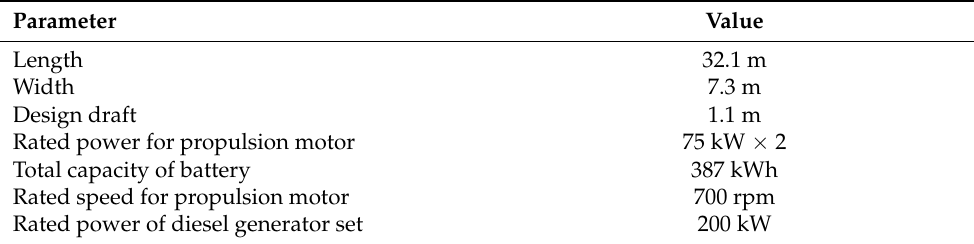
Table 1. Ship parameters.